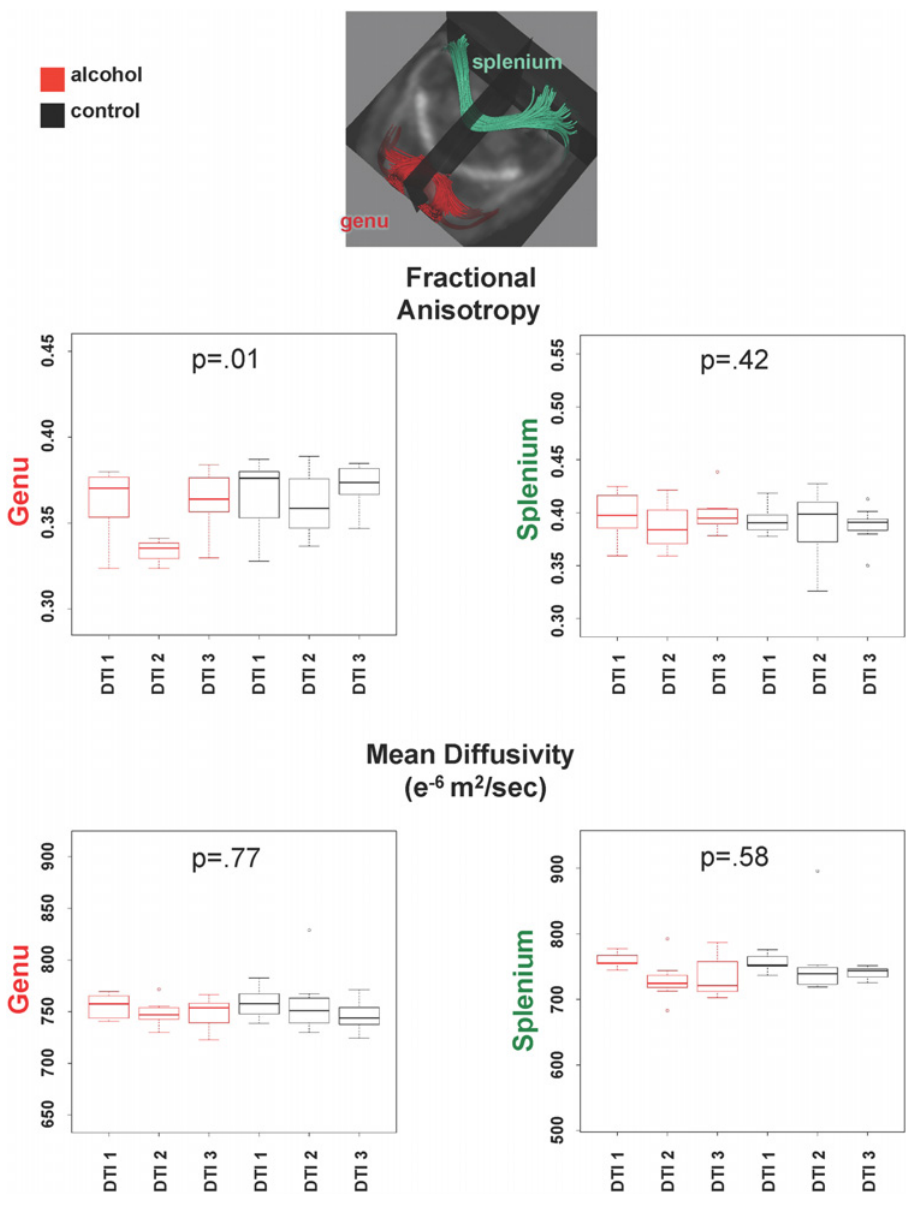
Fig 3. Inset shows fiber tracts of the genu (red) and splenium (green). Graphs show quantified results of FA (top) and MD (bottom) in corpus callosum genu and splenium. Dots here an in consequent graphs represent